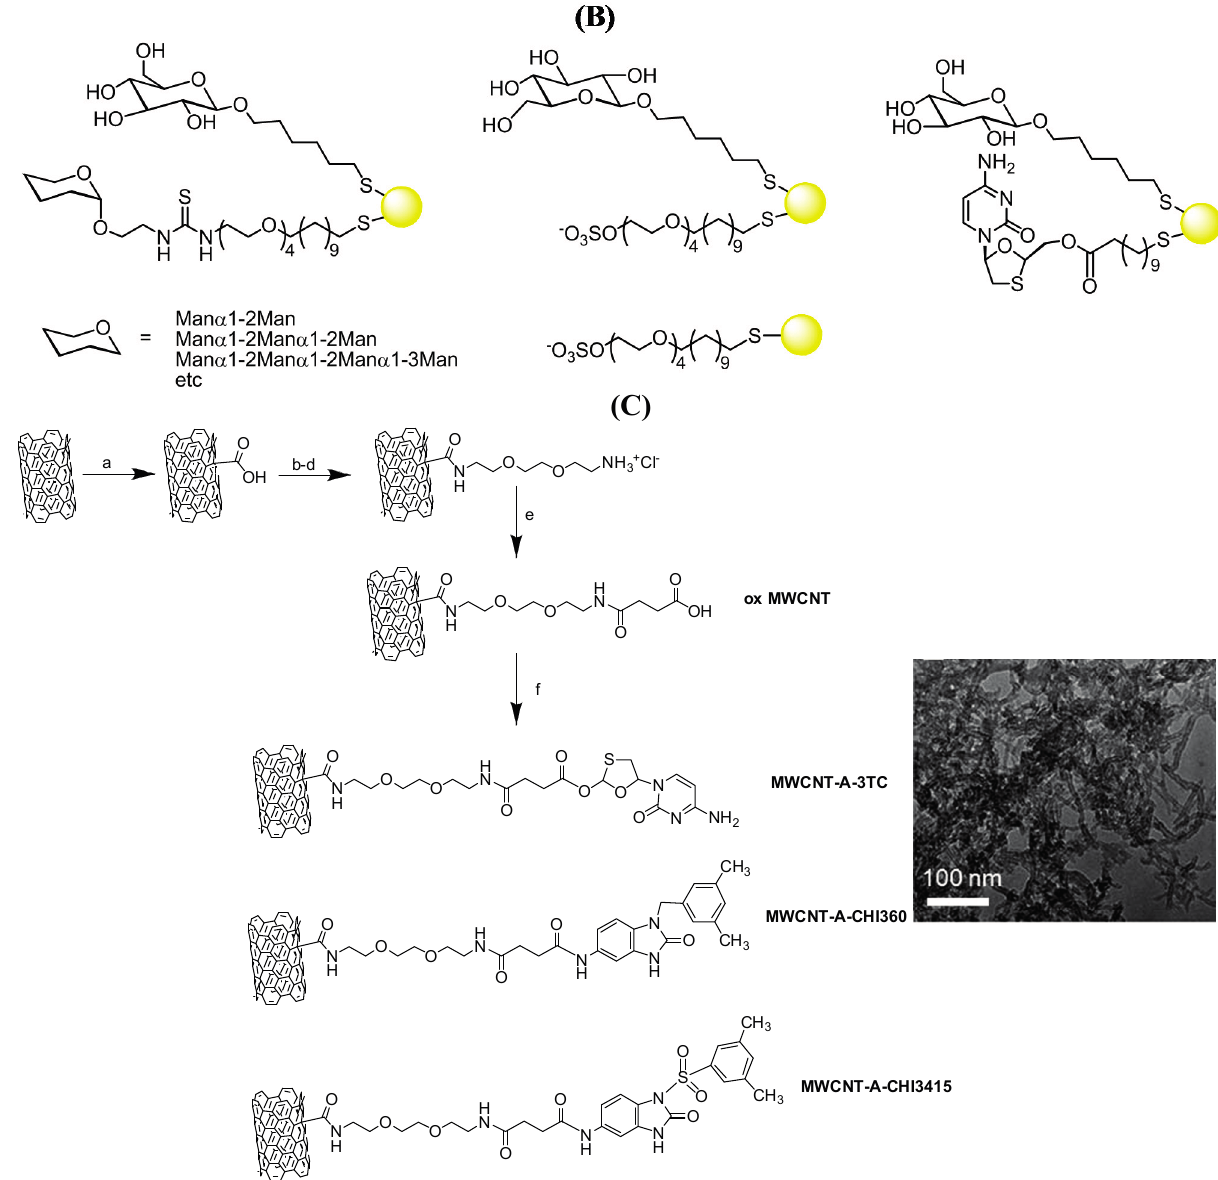
Figure 5. ( A ) Formation of SDC-1721-modified gold nanostructures via ligand exchange reaction, together with results of inhibition assay (reprint with permission from Ref. [62]); ( B ) Different gold-based anti-HIV scaffolds [65–68]; ( C ) Synthesis